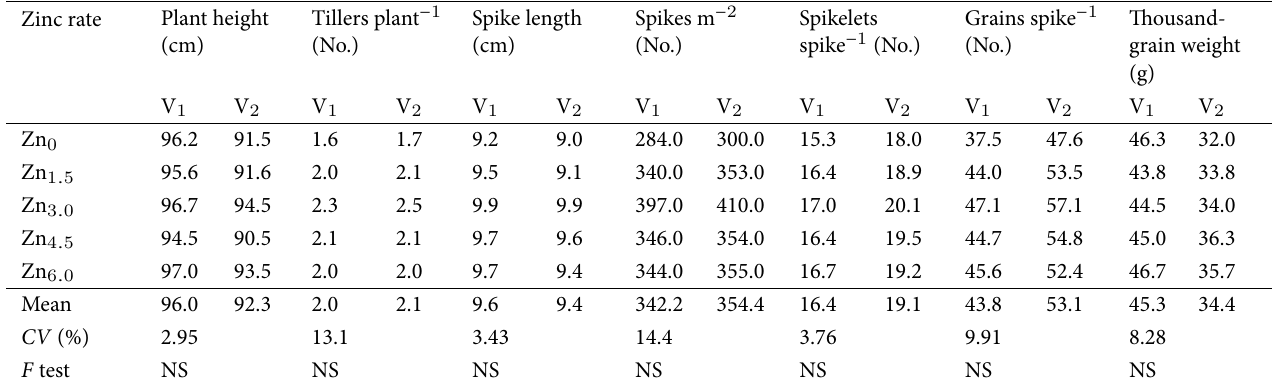
Table 3 Growth- and yield-contributing characteristics of wheat influenced by Variety × Zn Rate interaction. Zinc rate Plant